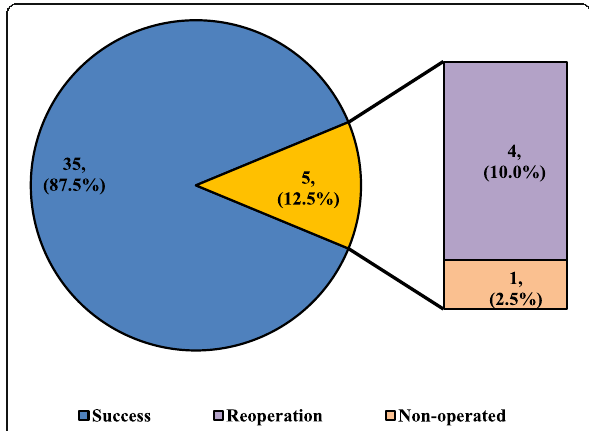
Fig. 3 Distribution of the studied group according to the outcome of endoscopic endonasal